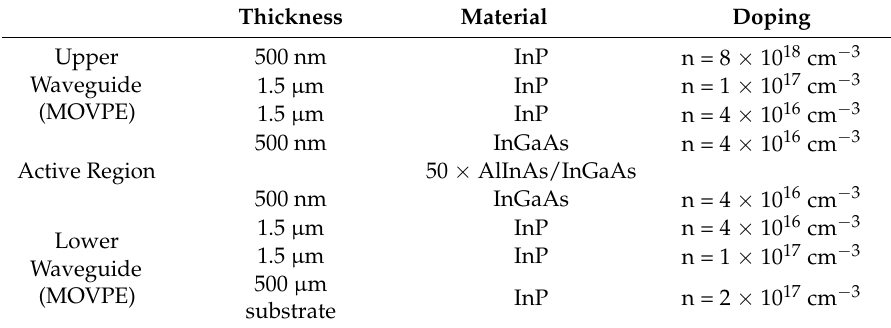
Table 1. The layer sequence of lattice matched Al 0.48 In 0.52 As/In 0.53 Ga 0.47 As/InP QCL structure.